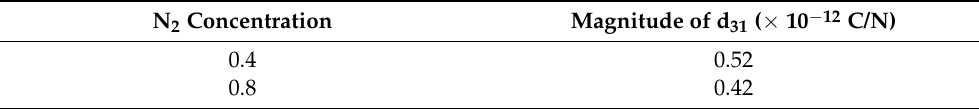
Figure 5. Output voltage (RMS value) V RMS experimental data obtained by cantilever beam set up with E RMS = 9.81 m/s 2 : ( a ) nitrogen concentration of 0.4; ( b ) nitrogen concentration of 0.8. Table 2. Magnitude of piezoelectric coefficient d 31 derived from fit of data obtained by cantilever beam set-up with AlN films. AlN films were deposited on aluminum substrates by magnetron sputtering at 0.3 Pa operative pressure and 150 W power value and nitrogen concentration set at 0.4 and 0.8,